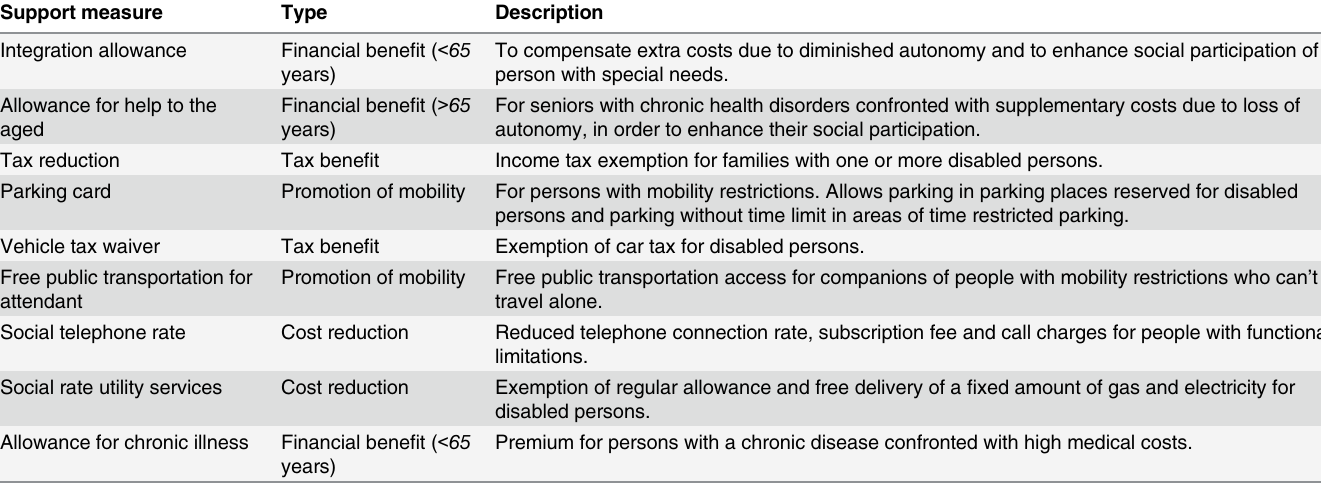
Table 1. Support measures for chronically ill patients investigated in this